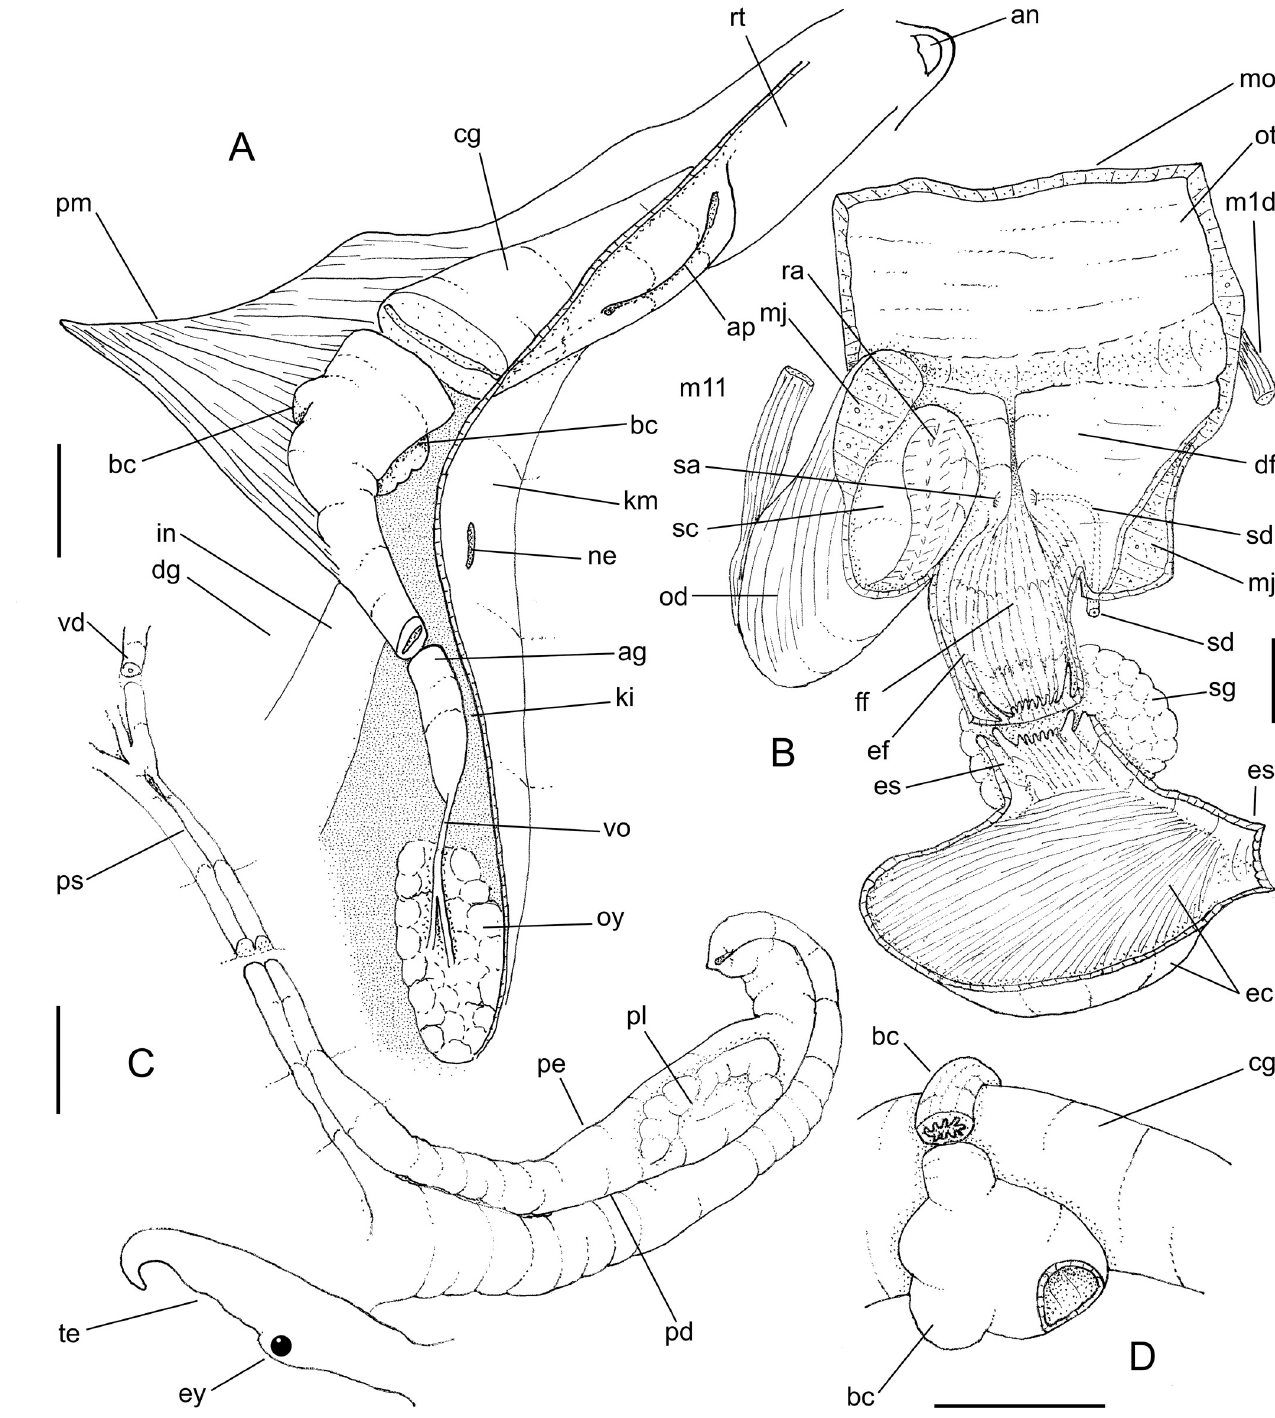
Fig 7. Macrocypraea mammoth anatomy. (A) Female genital system and adjacent structures as in situ, ventral view, transverse section artificially done in middle region of pallial oviduct, ovary (oy) only partially shown, kidney not shown in details. (B) Foregut, ventral view, opened longitudinally, odontophore (od) deflected to left. (C) Anterior male genital structures, dorsal view, topology of right tentacle (te) also shown. (D) Detail of middle region of pallial oviduct, dorsal view, bursa copulatrix (bc) artificially sectioned in two regions. Scales = 5 mm.